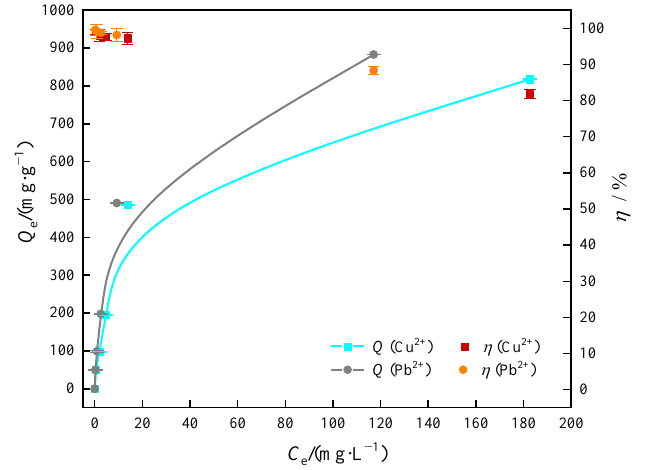
Figure 10. Adsorption isotherms of Cu(II) and Pb(II) on MOMMC ( C 0 = 1000 mg · L − 1 , pH = 5, T = 25 ◦ C, adsorbent concentration = 1 g · L − 1 , contact time = 120 min).